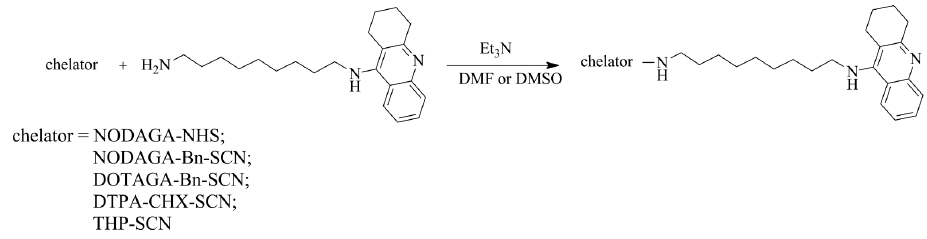
Scheme 1. The coupling reaction of chelator with NH 2 (CH 2 ) 9 Tac scaffold. Table 1. t R values of conjugates (system 2, UV detection), radioconjugates (system 1, gamma de- tection) and reference compounds (system 1, UV detection), and logD 7.4 values determined for